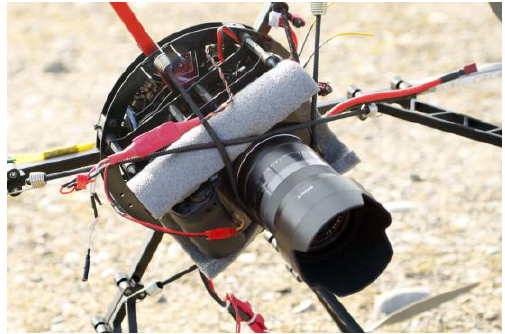
Figure 3: Sony RX1 in hexacopter pod with dampers.